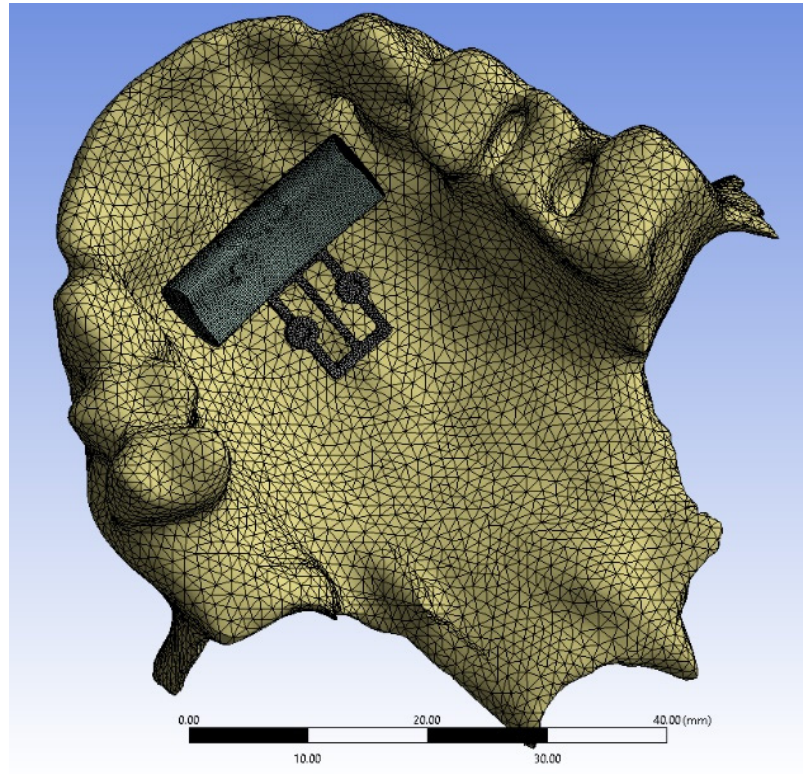
Figure 5. Hybrid computational mesh for the first mini-implant configuration.